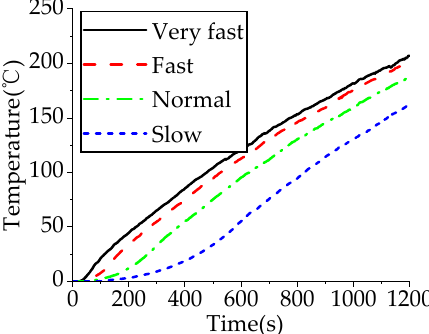
Figure 8. Temperature of the membrane above the fire.